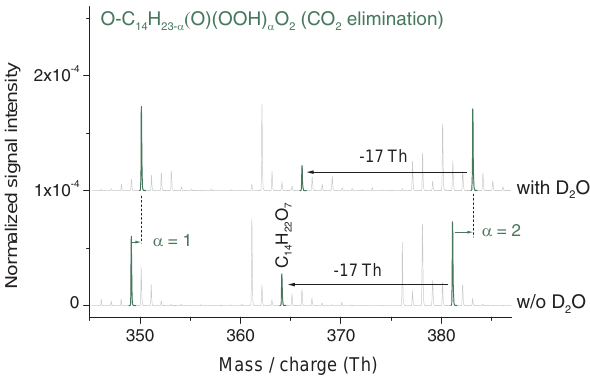
Figure 5. Ozonolysis of β -caryophyllene in the absence (lower part) and presence (upper part) of D 2 O applying nitrate ionization in the analysis. Highly oxidized RO 2 radicals of the product group ext. AutOx. -CO 2 , O–C 14 H 23 − α (O)(OOH) α O 2 with α = 1 and 2, and the corresponding closed-shell product (C 14 H 22 O 7 ) of the RO 2 radical with α = 2 are highlighted in green. The addition of D 2 O leads to an H/D exchange of the acidic H atoms being equal to the number of hydroperoxide groups in the molecules, i.e. a shift by one nominal mass unit for α = 1 or a shift by two nominal mass units for α = 2 (including the corresponding closed-shell product). [ β - caryophyllene] = 8 . 3 × 10 10 , [O 3 ] = 1 . 02 × 10 12 moleculescm − 3 , reaction time is